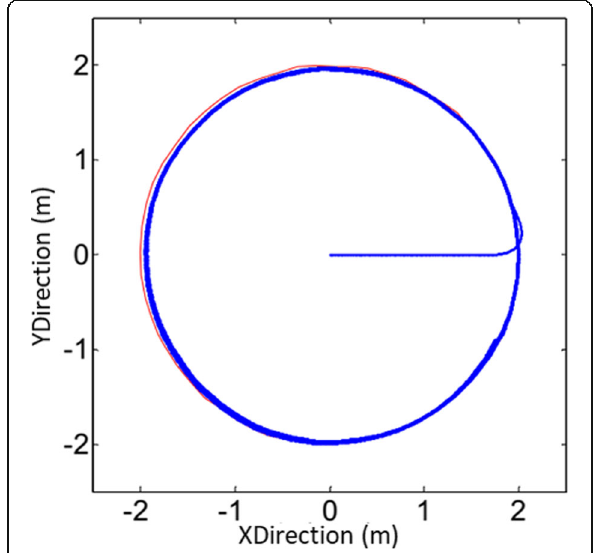
Fig. 7 Tracking results of a circular path